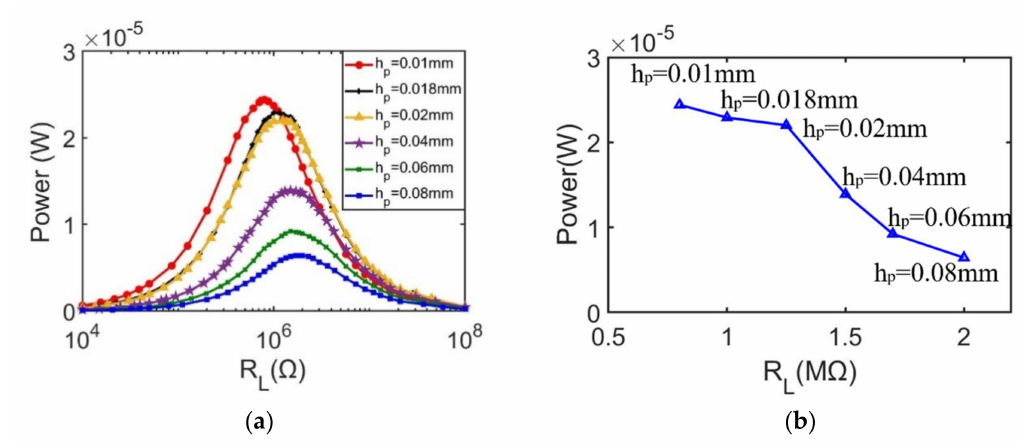
Figure 13. Resistance load matching results at the first vibration mode with different piezoelectric layer thickness. ( a ) output power responses with different piezoelectric layer thickness; ( b ) The maximum output power versus optimal load resistance corresponding to different piezoelectric layer thicknesses.